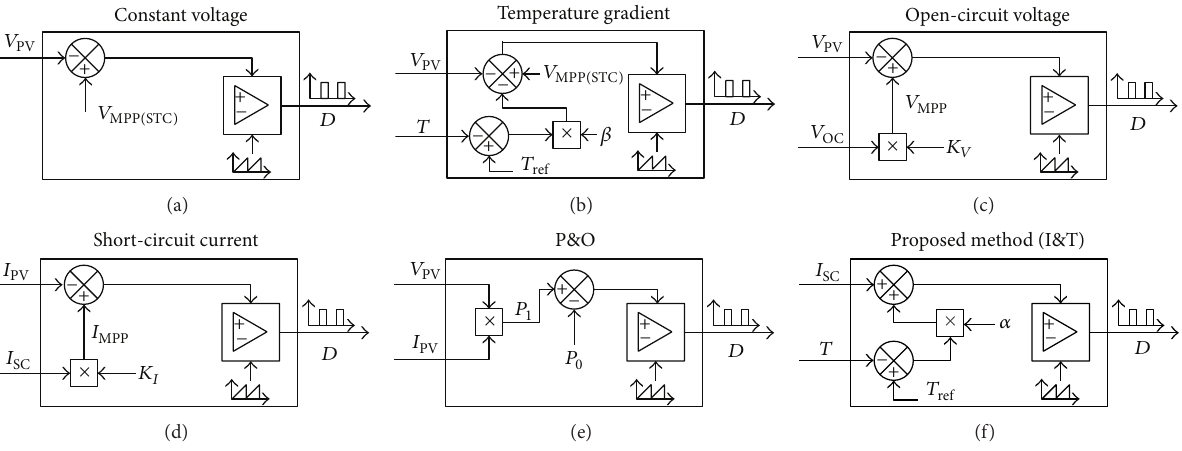
Figure 2: Block diagram representation of MPPT methods: (a) constant voltage; (b) temperature gradient; (c) open-circuit voltage; (d) short- circuit current; (e) P&O; (f)